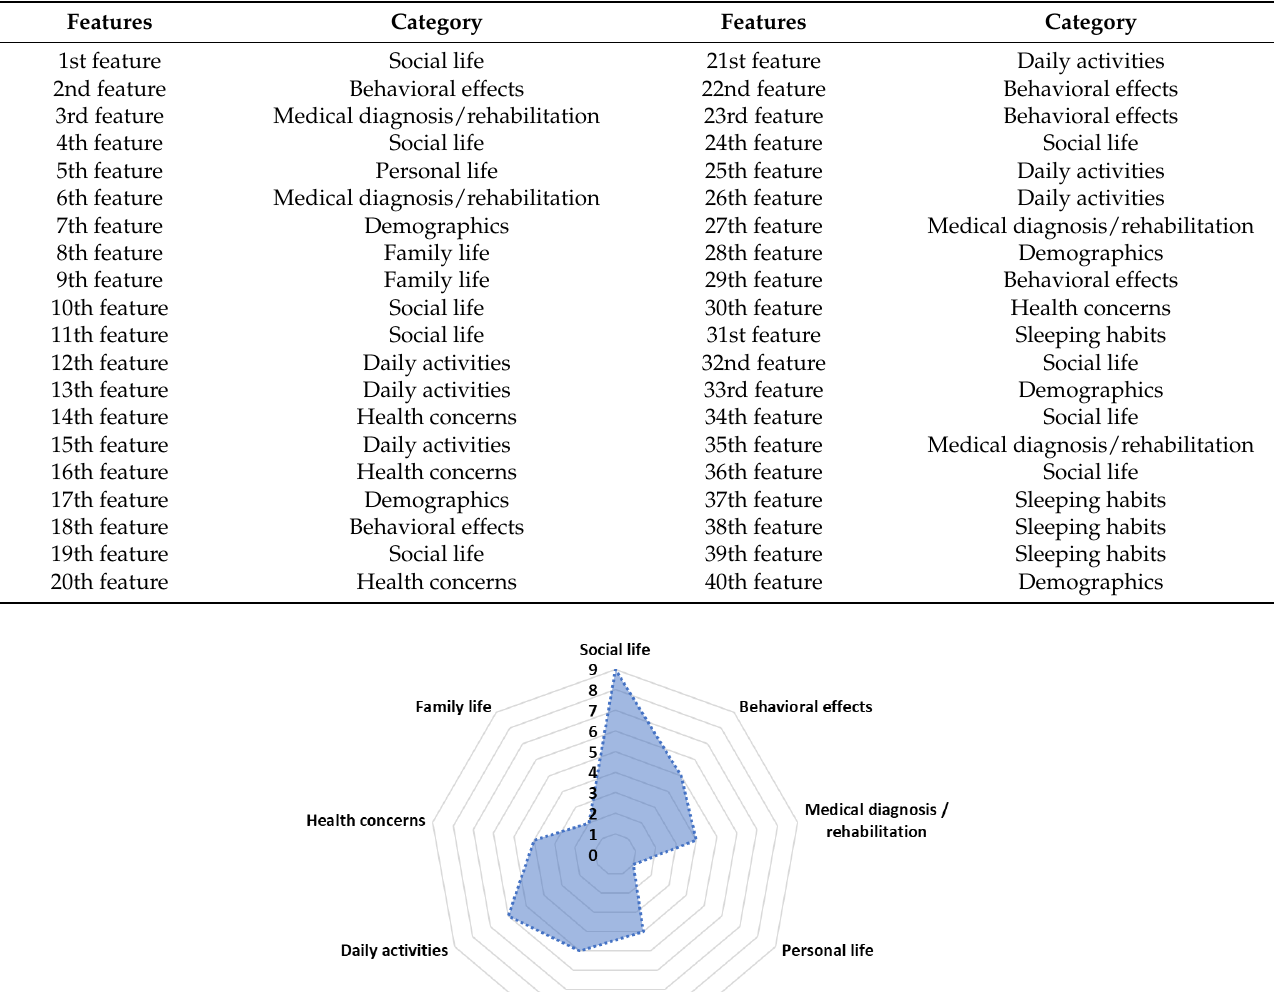
Table 10. Results from feature selection with the categories of the 40 first features.